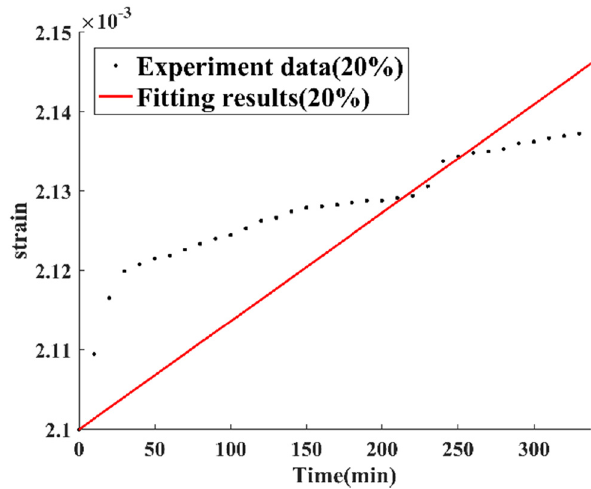
Figure 7: Fitting results based on the conventional Maxwell model and 20% stress